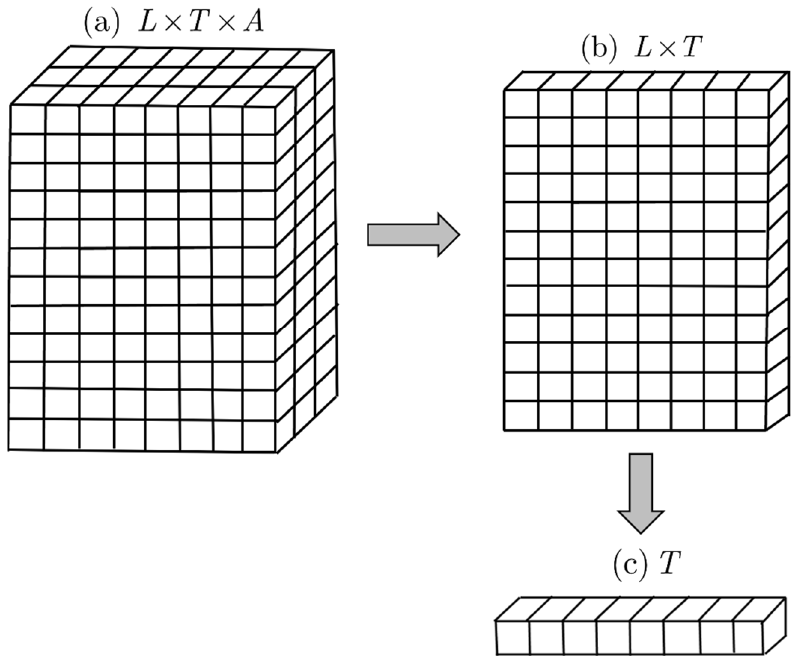
Figure 1. Simple examples of the ( a ) ternary, ( b ) binary, and ( c ) unary reference sets used in this work. The arrows correspond to set-theoretic projections from 𝐿 × 𝑇 × 𝐴 ⇒ 𝐿 × 𝑇 and from 𝐿 × 𝑇 ⇒ 𝑇 , respectively.